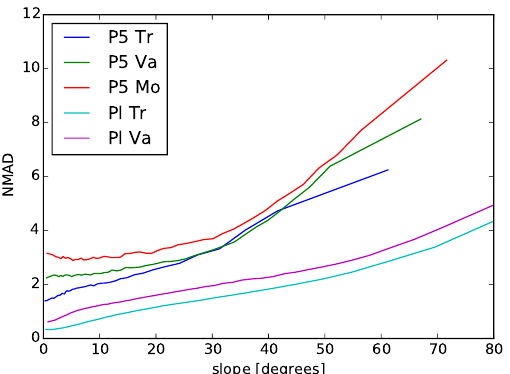
Figure 6: Dependence of height error on difference of first and second aggregated cost minima A mmn .